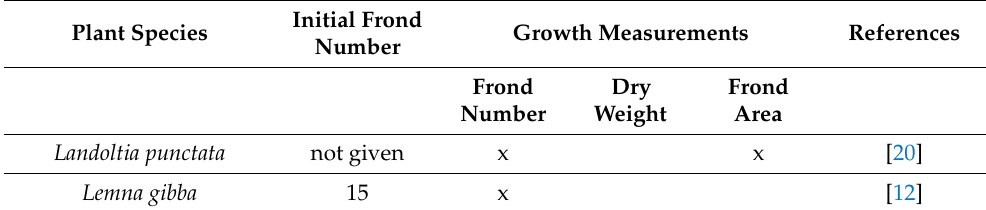
Table 2. Initial frond numbers and growth measurements used in studies involving silver nanoparti- cles and duckweed species (x indicates that the growth measurement was evaluated in the referenced